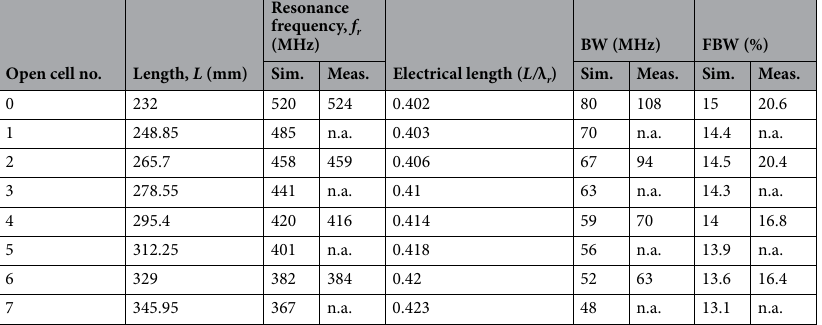
Table 1. Geometrical and electrical parameters characterizing the dipole antennas at the fundamental resonance for variable number of void loops in the kirigami strips forming the dipole arms. Data from measurements and simulations are